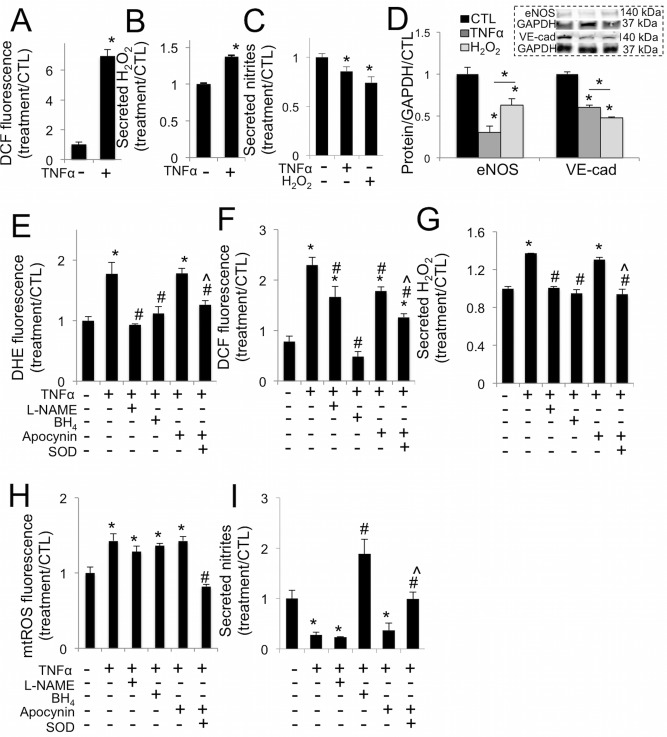
TNFα drives increased oxidative stress in aortic valve endothelial cells via eNOS uncoupling.
A, TNFα increases oxidative stress in VEC at 30 minutes. B, TNFα increases hydrogen peroxide (H2O2) secretion from VEC at 30 minutes. C, TNFα or H2O2 decrease nitric oxide secretion from VEC at 48 hours (n = 4). D, TNFα or H2O2 decrease eNOS and VE-cadherin expression in VEC at 48 hours. Representative western blot images (inset) and blot quantification. E, L-NAME, BH4, or peg-SOD but not apocynin block increases in superoxide (DHE) in VEC caused by TNFα, at 30 minutes. F, L-NAME, apocynin, and peg-SOD mitigate increases in general oxidative stress (DCF) caused by TNFα at 30 minutes, but only BH4 completely blocks superoxide increase, maintaining control levels. G, L-NAME, BH4, or peg-SOD but not apocynin block increases in H2O2 secreted by VEC at 30 minutes caused by TNFα at 30 minutes. H, TNFα drives increased mtROS, mitigated only by co-treatment with SOD. I, BH4, or peg-SOD but not L-NAME or apocynin block decreases in nitric oxide secretion in VEC caused by TNFα at 48 hours. * indicates p < 0.05 versus control. # indicates p < 0.05 versus TNFα. ^ indicates p < 0.05 versus apocynin. N = 4.